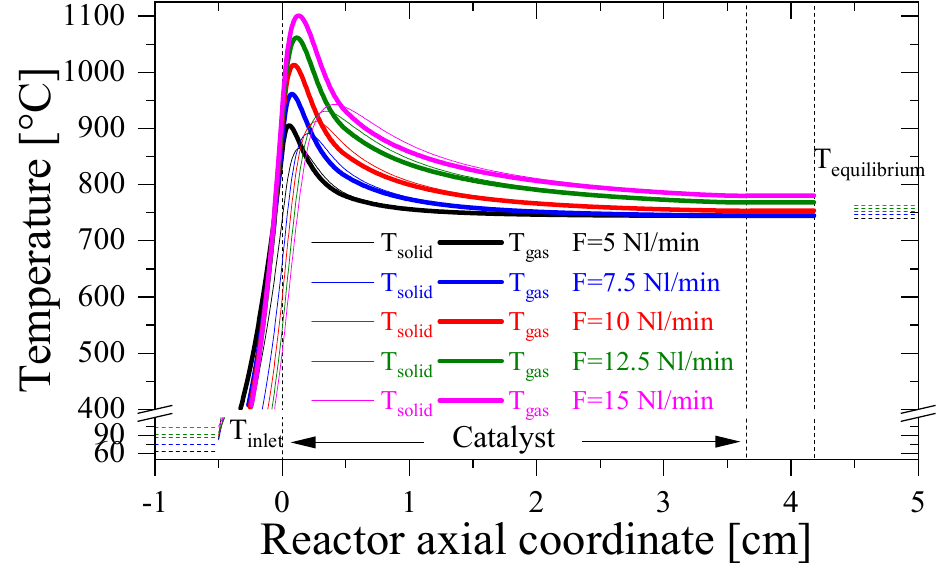
Figure 4. Simulated temperature profiles varying the inlet flow rate. Feed composition: iC8 = 3%, air with C / O = 0.9 and N 2 complement. Very good agreement with the experimental results was obtained, since the calculations showed a progressive increase of the whole temperature profiles and an especially important increase of temperatures in the hot spot at the monolith entrance.